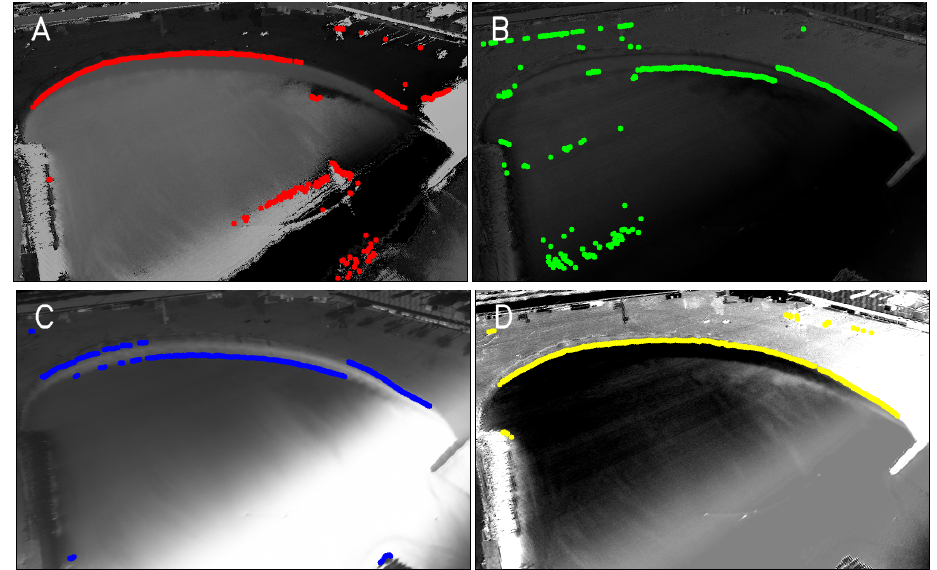
Figure 6. Examples of ( A ) Hue channel, ( B ) Saturation channel, ( C ) Value channel and ( D ) Red over Green channels, with the corresponding raw shorelines, of beach BCN3 on 7 November 2017 at 11 h (same planview as in Figure